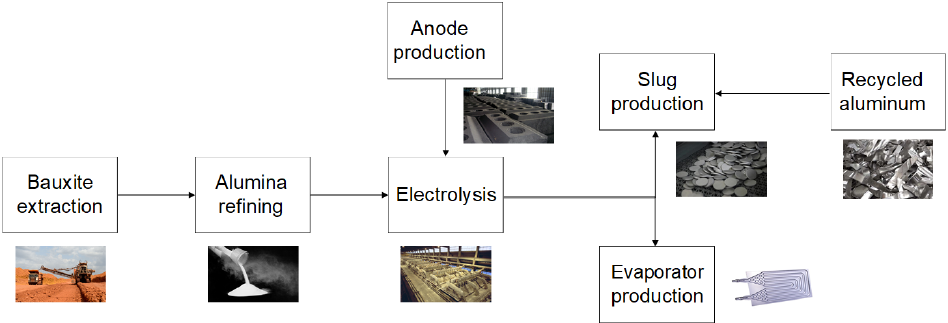
Figure 1. Production of aluminum slugs and evaporator panels (modified from [47]).